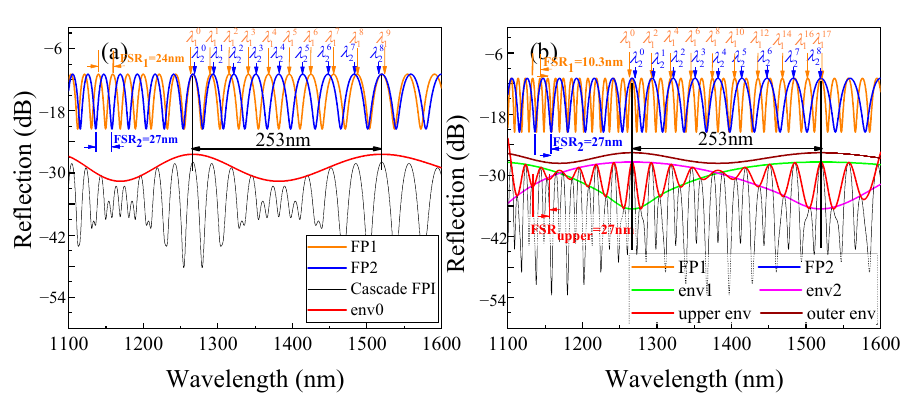
Figure 3. The spectra of FP1, FP2, and cascaded HVE FPI at ( a ) i = 0 and ( b ) i = 1. According to Equations (4) and (5), both i and ∆ can be adjusted by tuning the OPL ratio between FP1 and FP2. To investigate the difference between TVE and HVE FPIs, a different OPL ratio is chosen and studied. The calculated spectra for individual FP1 and FP2 at i = 0 ( L 1 = 34.2 µ m, L 2 = 20 µ m, and ∆ = 3.8 µ m) are shown in Figure 3a. The